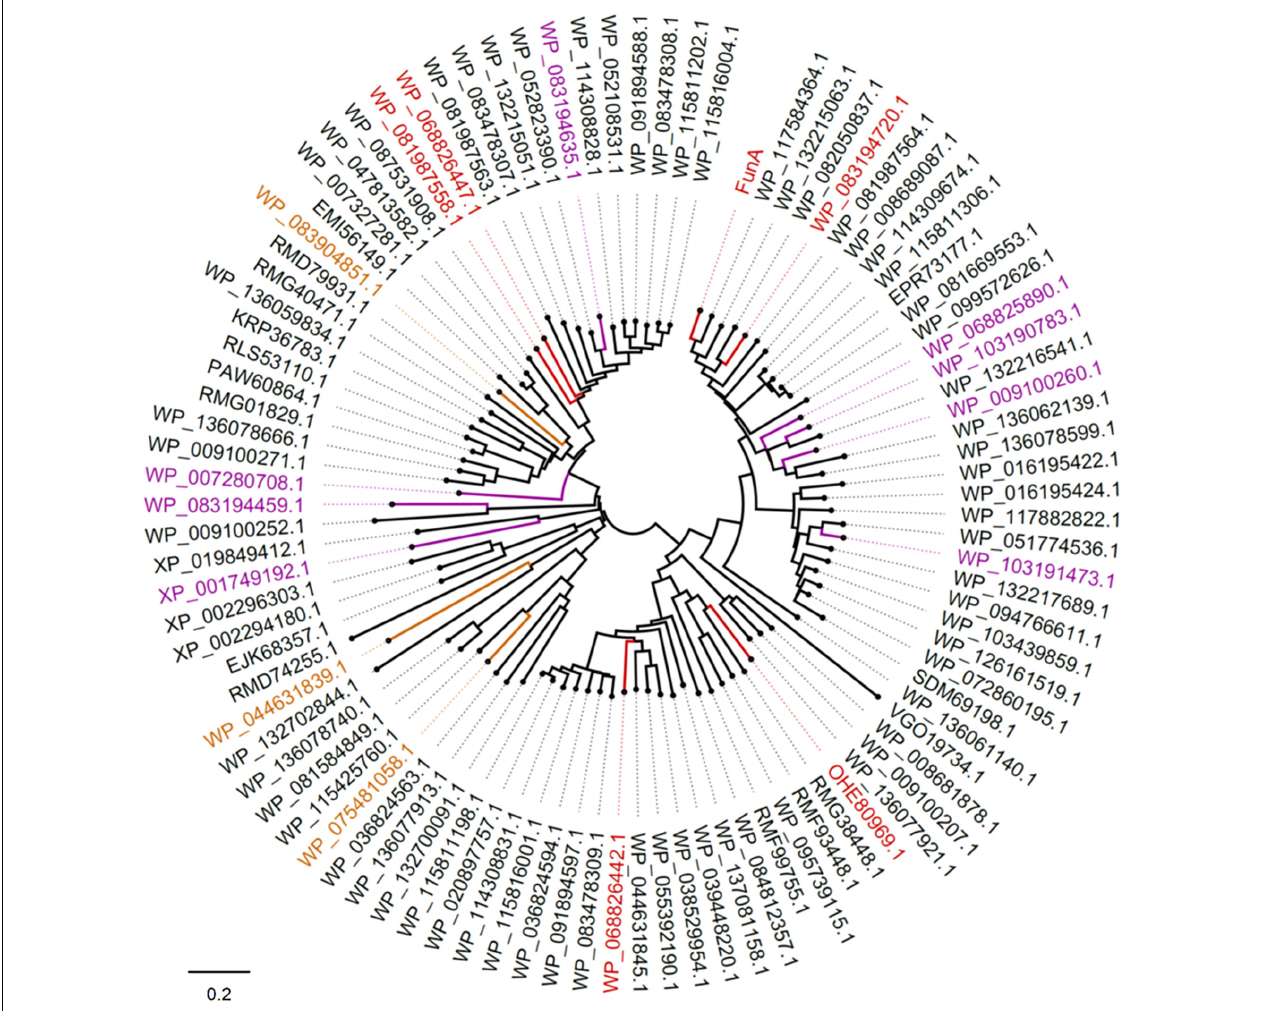
FIGURE 5 | Phylogenetic analysis of FunA and its homologs. Sequences successfully expressed in the supernatant of E. coli cell lysate were highlighted: sequences exhibited activity on Ib-FUC were in red; sequences with no activity on Ib-FUC were in purple; sequences expressed in inclusion body were in yellow.